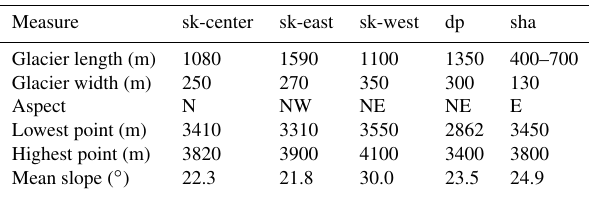
Table 5. Characteristics of the glaciers listed by catchment where we identified detachments and rock-ice avalanches. Measure sk-center sk-east sk-west dp sha Glacier length (m) 1080 1590 1100 1350 400–700 Glacier width (m) 250 270 350 300 130 Aspect N NW NE